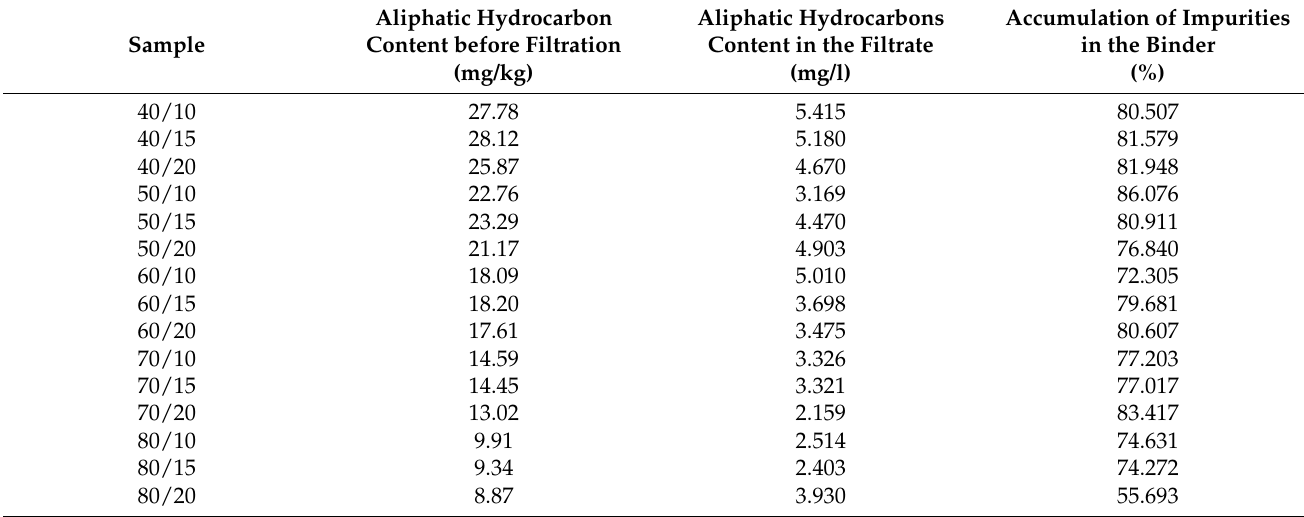
Table 3. Aliphatic hydrocarbon contents before and after the filtration